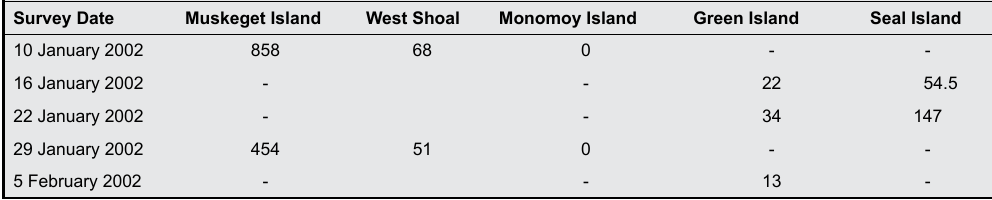
Table 1 . Average number of grey seal pups counted at each of the 5 sites surveyed for each survey date.